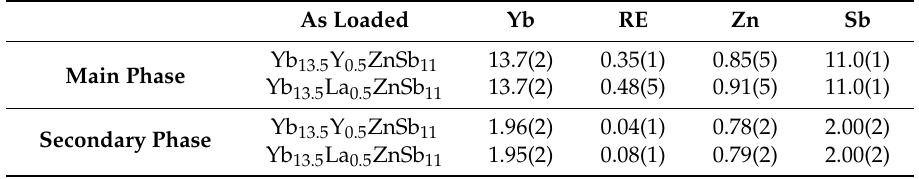
Table 1. Wavelength dispersive X-ray spectroscopy (WDS) stoichiometry from pelleted samples from an average of 15 data points (main phase) and an average of 5 points (side phase). RE—rare earth.